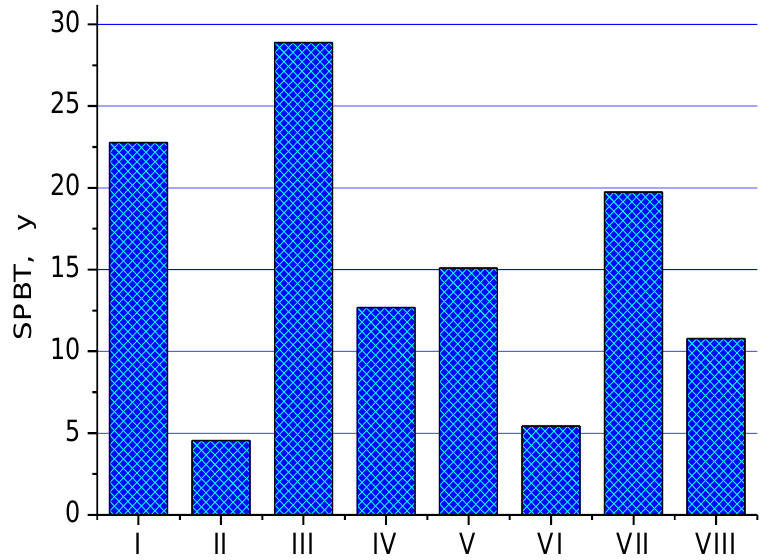
Figure 3. Simple repayment time (SPBT) in years for each option analyzed (methods I to VIII according to Table 1).